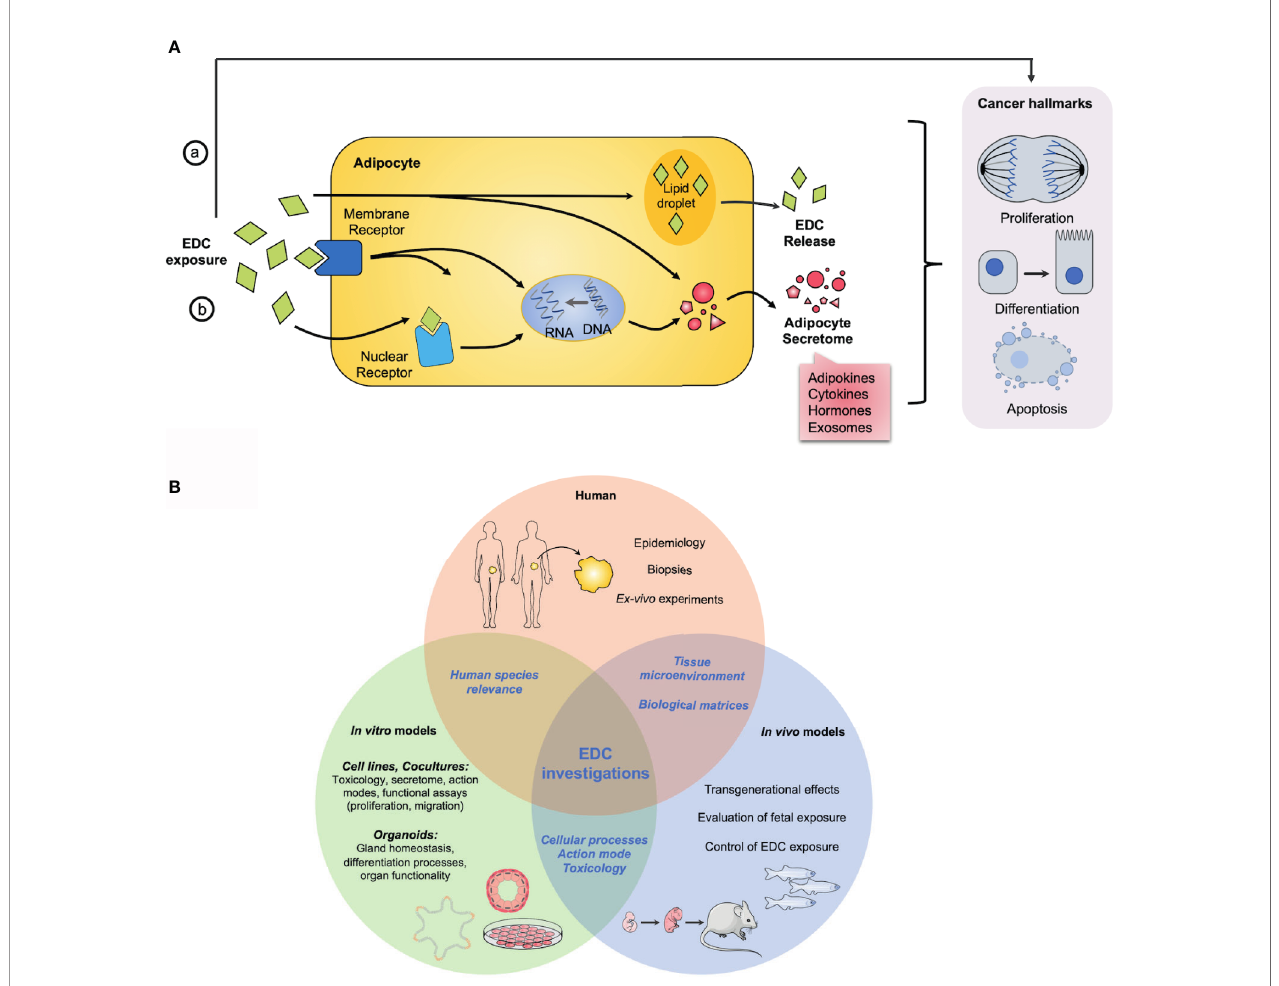
FIGURE 1 | Overview of EDCs action in adipocytes and cancer cells and models to study EDCs. (A) Potential or hypothetical model of how EDCs can interfere in hormone sensitive cancer development or progression with adipocytes. EDCs can act a) directly on hormone-sensitive cells to modify their physiology and/or function to induce or exacerbate cancer hallmarks and/or b) on adipocytes by interfering with (i) nuclear or (ii) membrane receptors to modulate adipocyte secretome through genomic or non-genomic pathways, otherwise EDCs can be stored in (iii) lipid droplets and be released, progressively during all the life or massively as observed after a weight lost. (B) Requirement of complementary approaches to investigate impact of EDCs on health. Main questions and assays from in vitro and in vivo models to